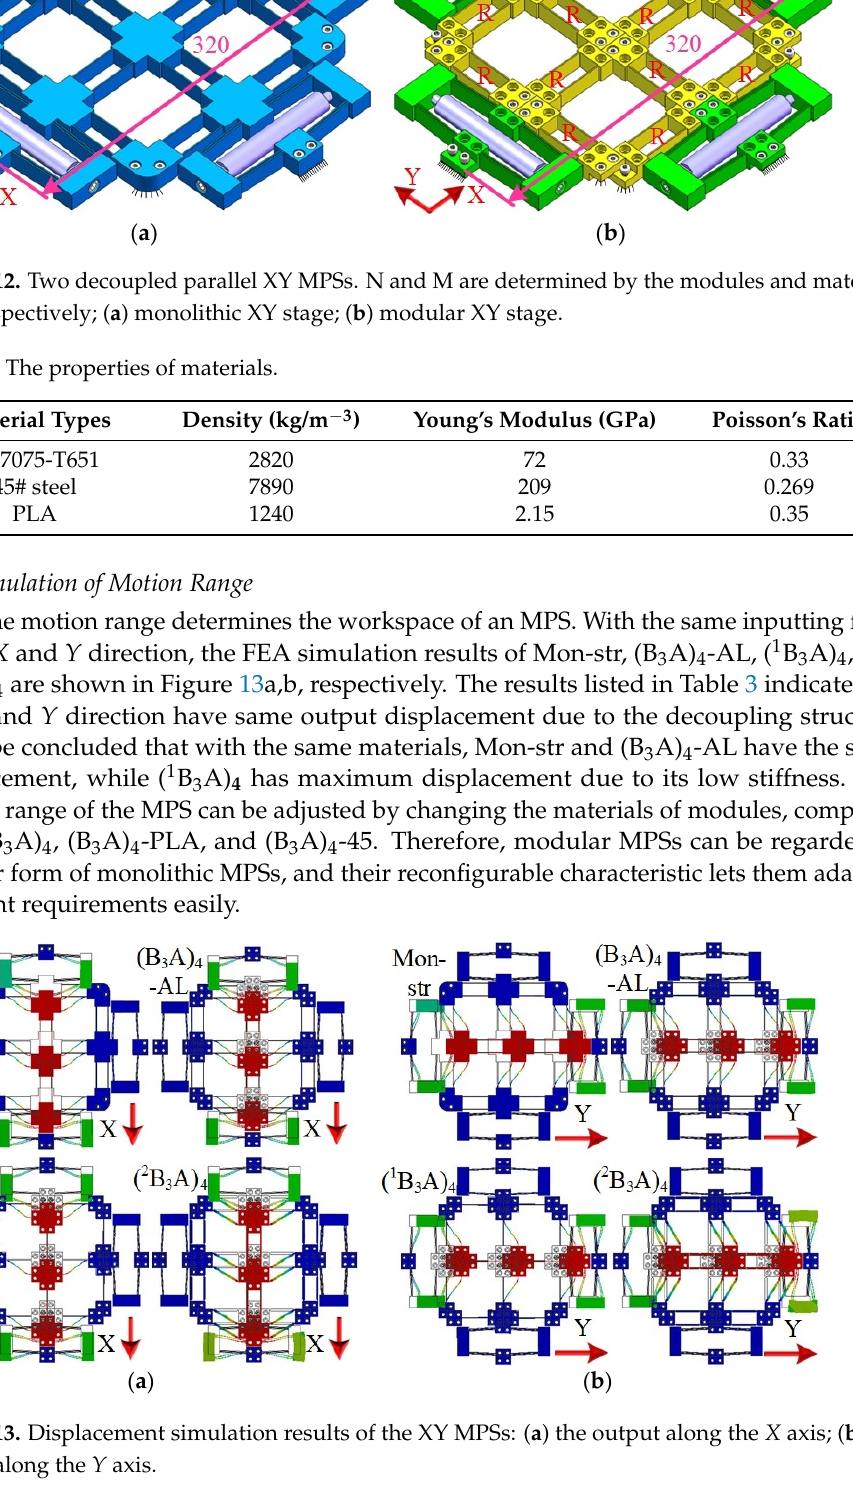
Figure 13. Displacement simulation results of the XY MPSs: ( a ) the output along the X axis; ( b ) the output along the Y axis. Table 3. Analysis results of different decoupled parallel XY MPSs.